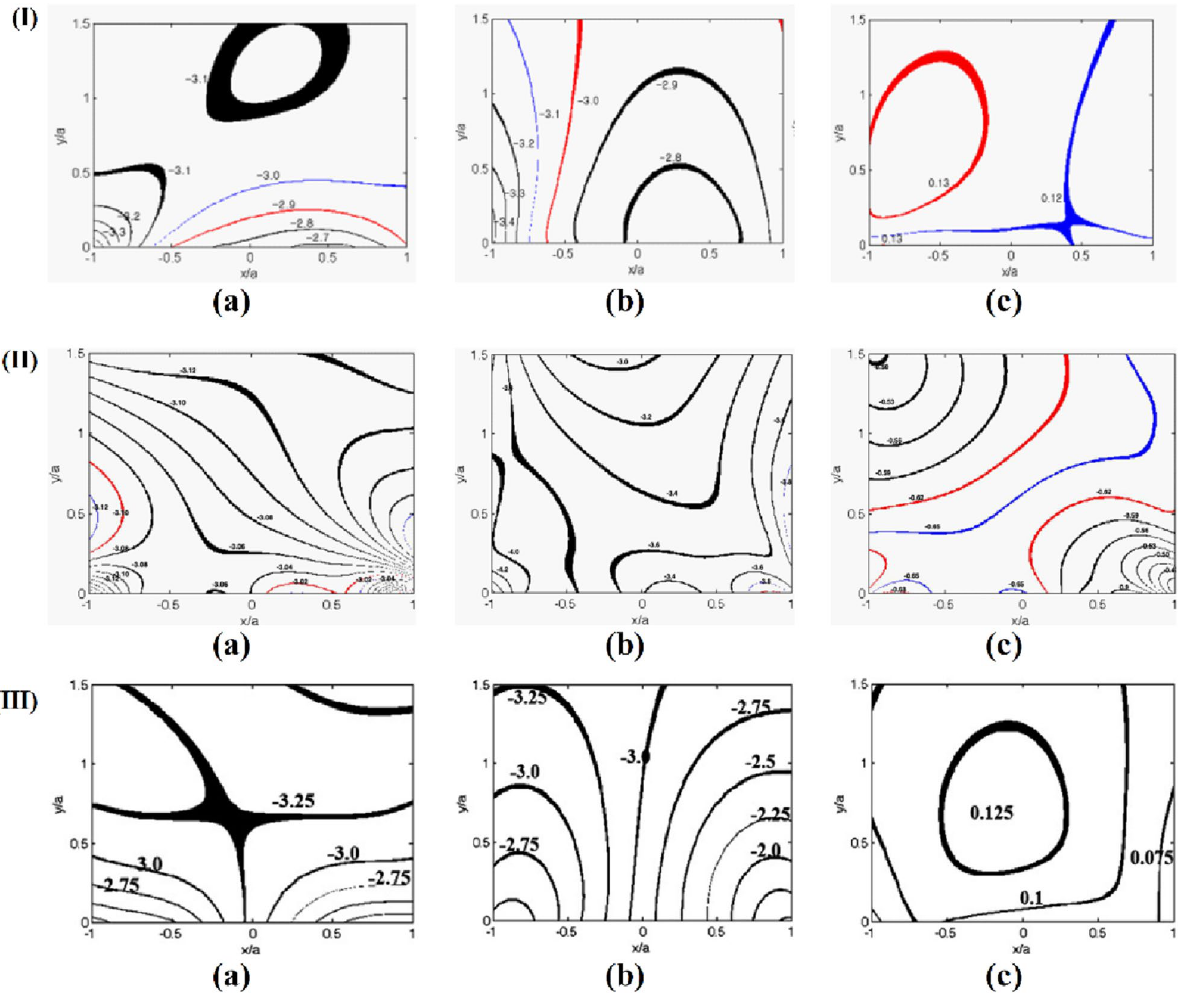
Figure 9. The internal stress contours on the upper region of; (I) D-ring, (II) Square ring, and (III) X-ring under uniform compression of 20% normalized by internal pressure ( P i ) of 1 MPa. (a), (b), and (c) represents σ X /P i , σ Y /P i , and τ XY /P i respectively.